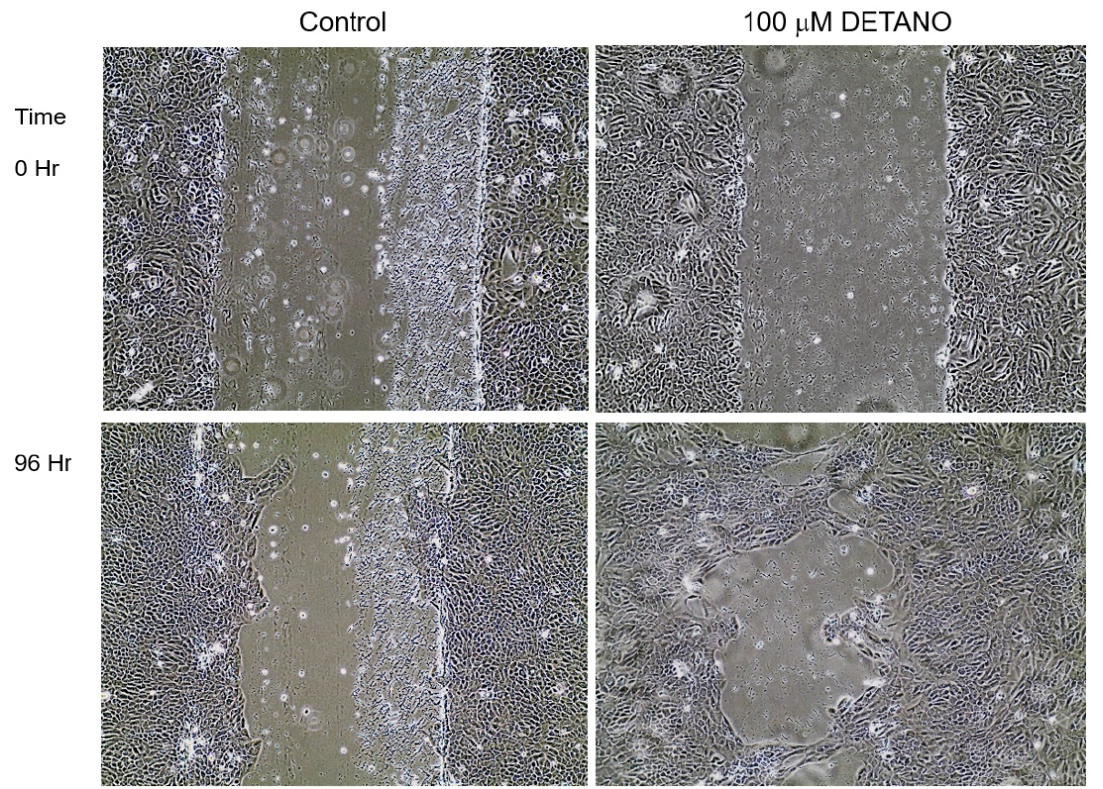
Figure 2. Scratch Test. NO treatment was withdrawn and MCF10A cells were seeded in 60 mm dish and grown to confluence in complete media without treatment. Upon reaching confluence, a straight line was scratched across each confluent monolayer using a 1000 µ L pipette tip and the cells were allowed to close the gap in the absence of NO treatment. Top panels show the Control ( left ) as well as cells that had been maintained in 100 µ M DETANO ( right ) treated MCF10A cells at time 0. The bottom panels show the same cells at 96 h; when compared to the untreated control, MCF10A cells that had been maintained in 100 µ M DETANO closed the gap